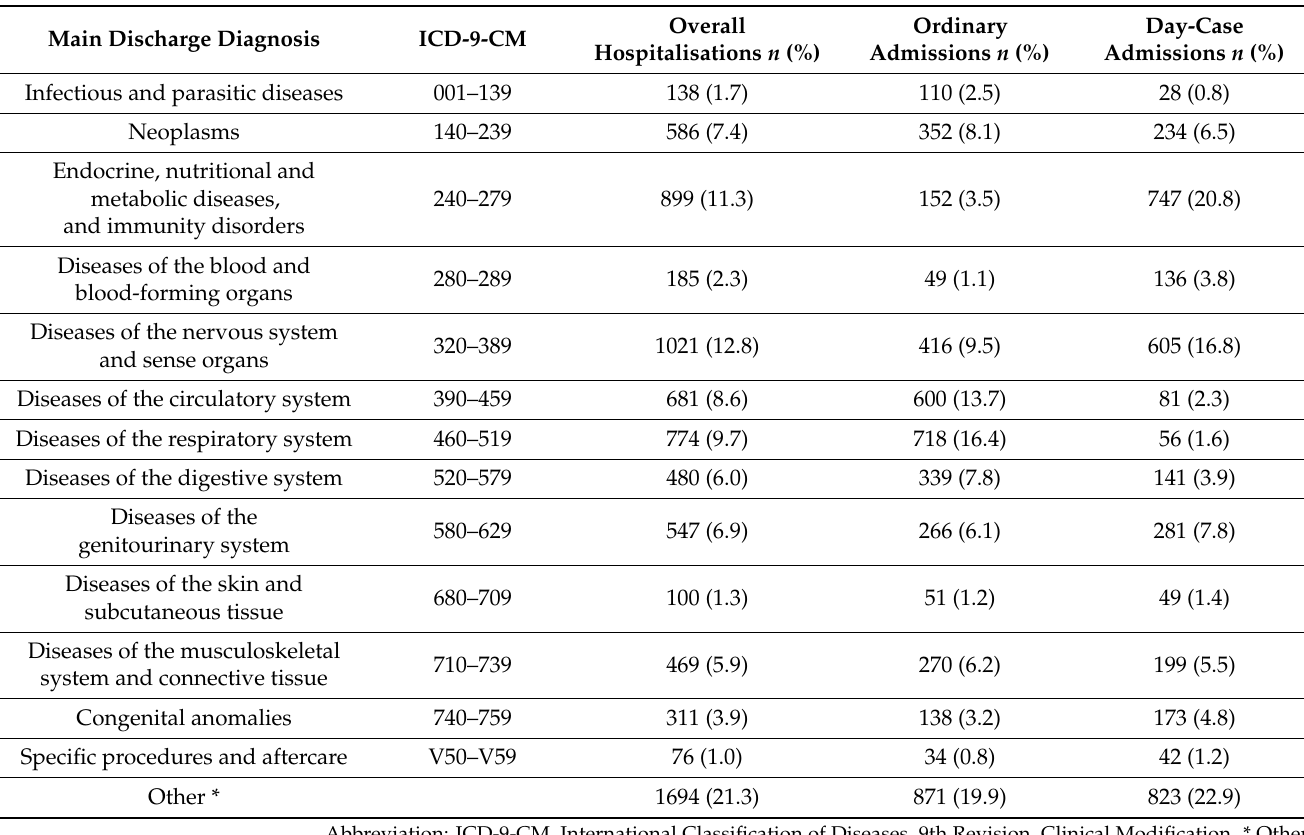
Table 1. Main discharge diagnosis for overall inpatients in